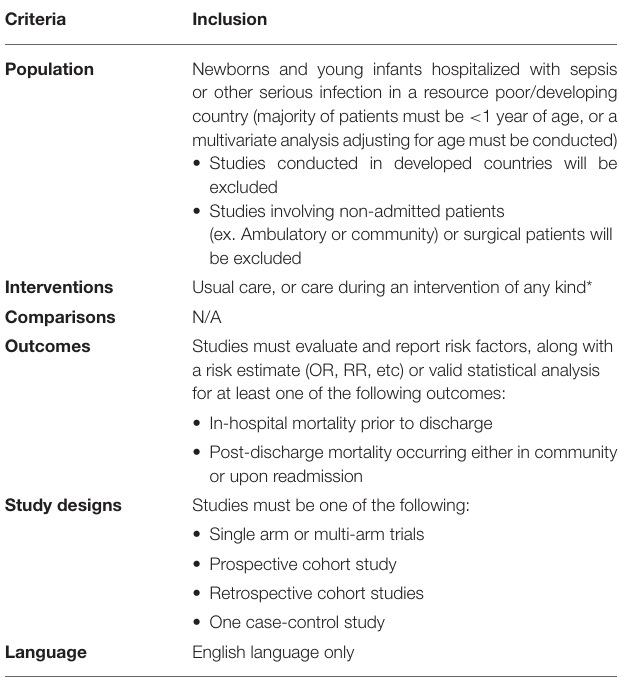
TABLE 1 | PICOS criteria outlining study